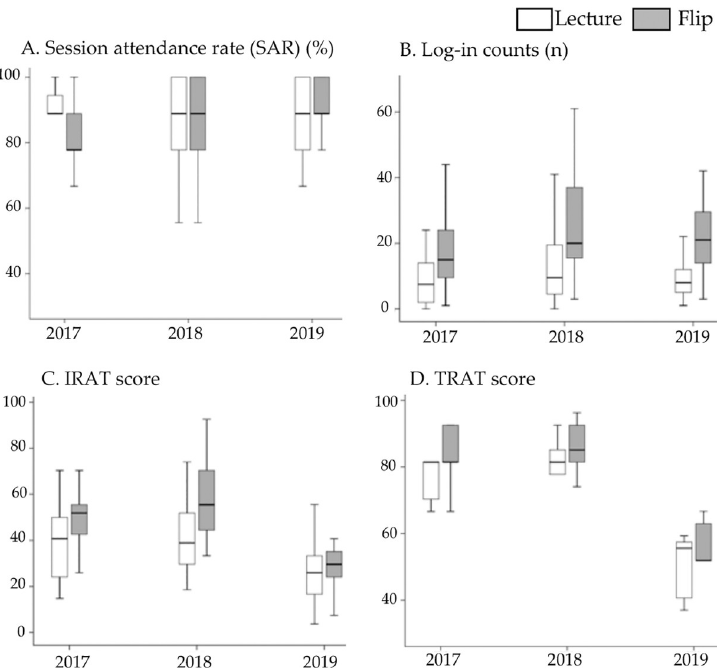
Fig 2. Participant behaviors and learning outcomes. Boxplots of participant behaviors (A, B) and learning outcomes (C, D). A, session attendance rate (%); B, number of online accesses (log-in counts) during the course period; C, IRAT (individual readiness assurance test) score; D, TRAT (team readiness assurance test) score.